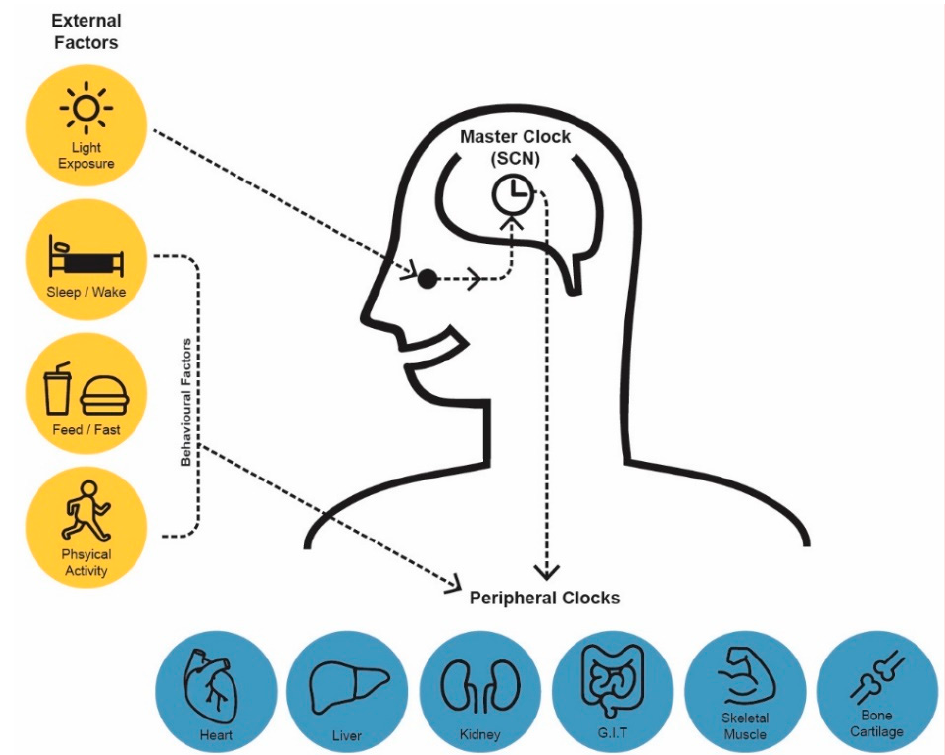
Figure 1. Human Circadian System: Comprised of a central clock and peripheral clocks. The central clock located in the hypothalamus is entrained by light. Peripheral clocks are influenced by physiological / behavioural factors such as sleeping and eating. Synchonisation of peripheral clocks, under the orchestration of the central clock, is essential to achieve circadian